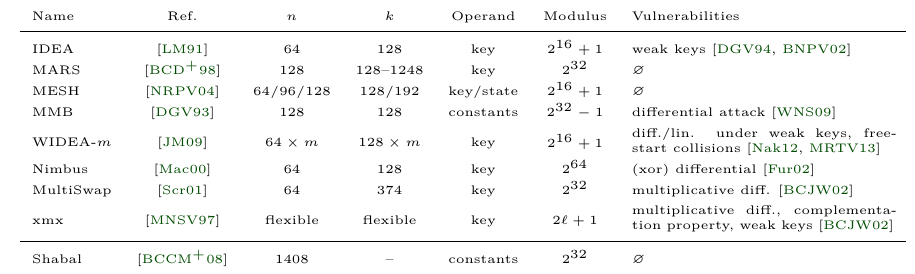
Table 1: Some cryptographic primitives using modular multiplication. n is the block size and k the key size (in bits). MultiSwap also uses a 64-bit initialization